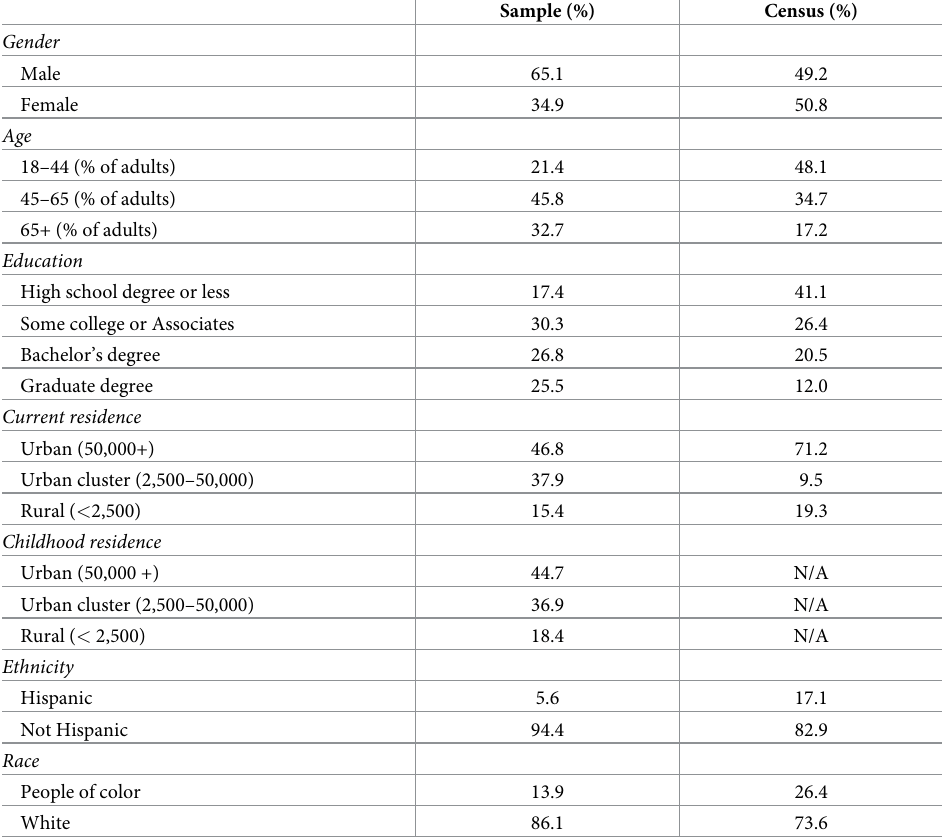
Table 2. Demographics from the survey sample compared to the U.S. census bureau.